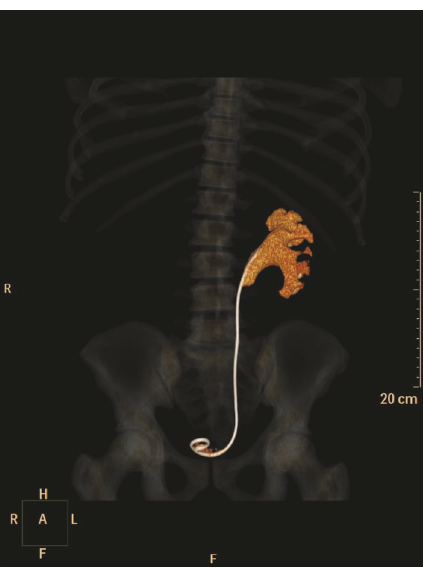
Figure 1: Abdominal computed tomography (coronal cut) showing complete coraliform calcification on double-J stent.